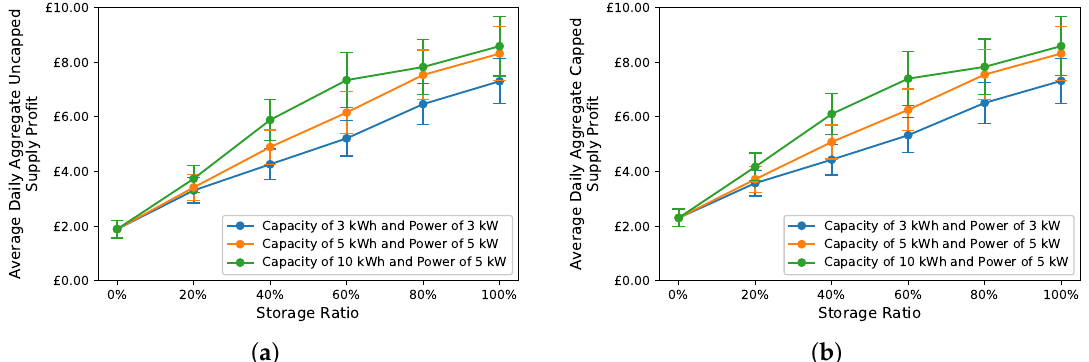
Figure 13. Comparison between average daily SP K and (cid:100) SP K . Increasing the storage ratio and capacity increase both profits. The reduction from the uncapped bill approach is still present. However, it is insignificant due to high supply profit and low supply shortage fees as more prosumers become flexible. The error bars represent 95% confidence intervals. ( a ) Average daily SP K . ( b ) Average daily (cid:100) SP K